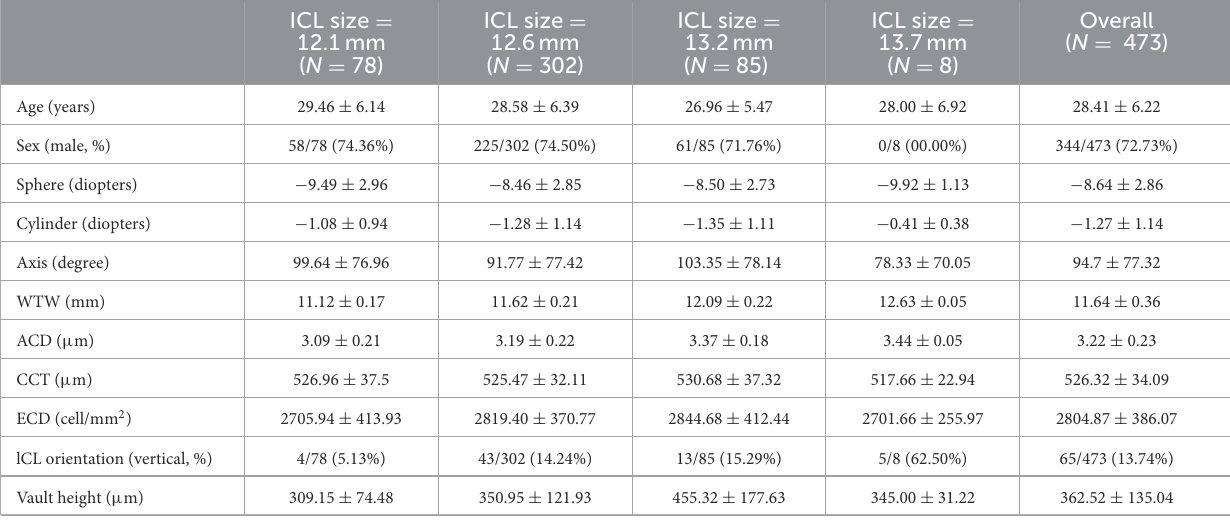
TABLE 1 Preoperative clinical characteristics, ICL orientation and vault height of patients undergoing ICL